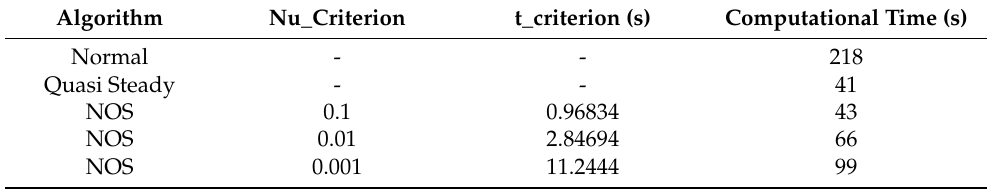
Table 1. Computational time-consuming comparison of three different